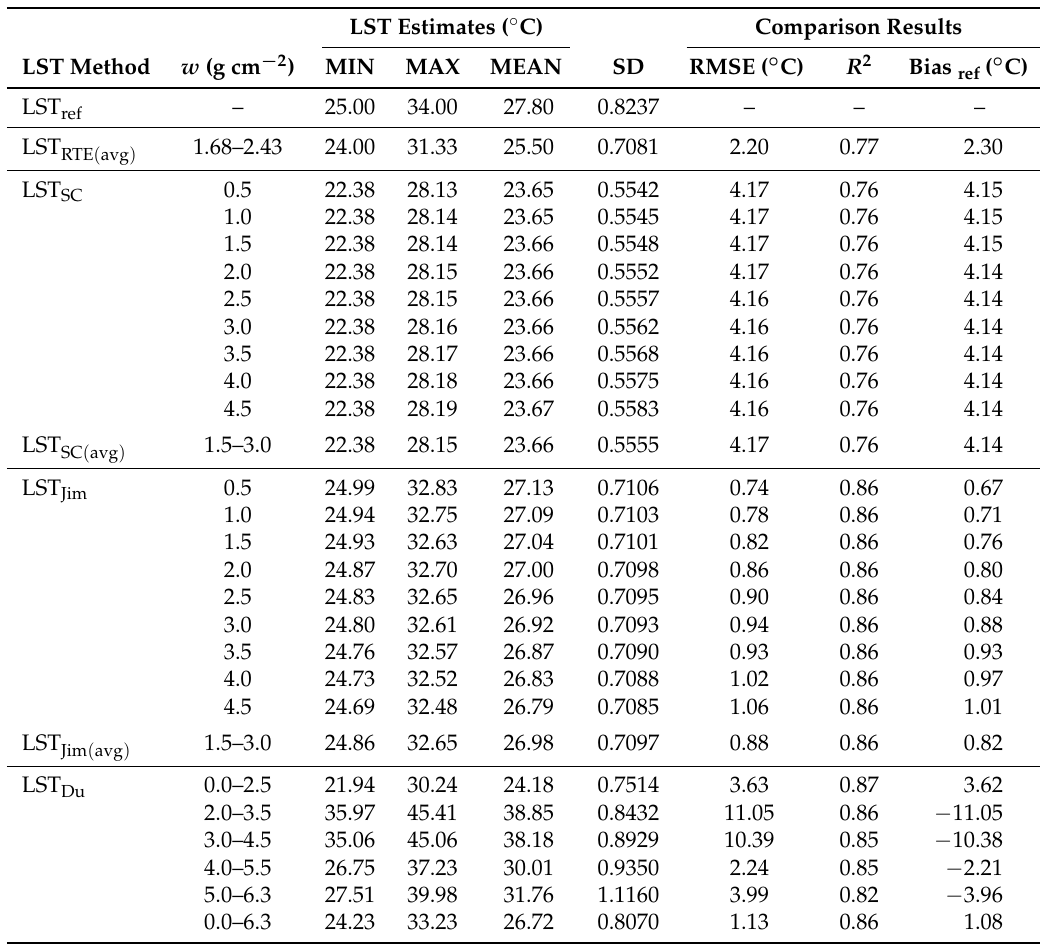
Table 7. Intercomparison results of LSTs retrieved with four algorithms from Landsat 8 data (21 February 2018) against reference LSTs.